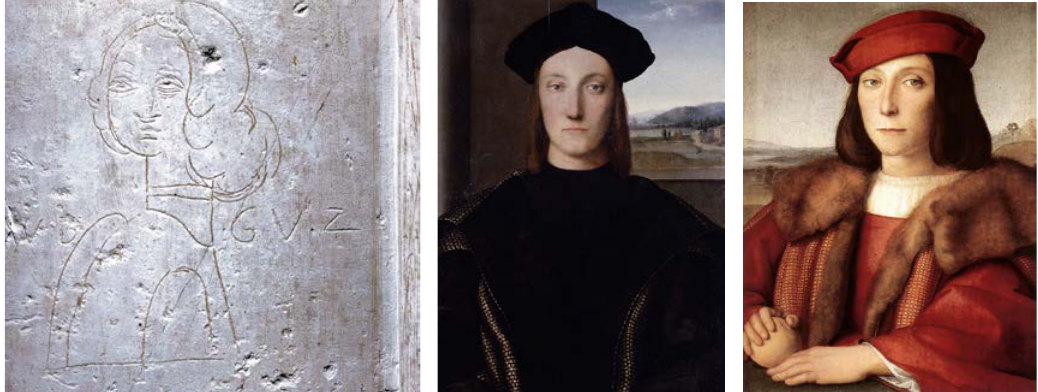
Figure 4 – From left to right: Graffito of a gentleman (Duke Guidobaldo da Montefeltro?). Photo by Manuele Marraccini; Raffaello Sanzio (attributed to), Ritratto di Guidobaldo da Montefeltro (?), Galleria delle Statue e delle Pitture degli Uffizi, Inv. 1890 n. 1441, detail; Raffaello Sanzio (attributed to), Ritratto di Francesco Maria della Rovere (?), Galleria Palatina e Appartamenti Reali, Inv. 1890 n. 8760, detail. Courtesy of Ministero per i beni e le attività culturali e per il turismo. Further reproduction or duplication by any means is